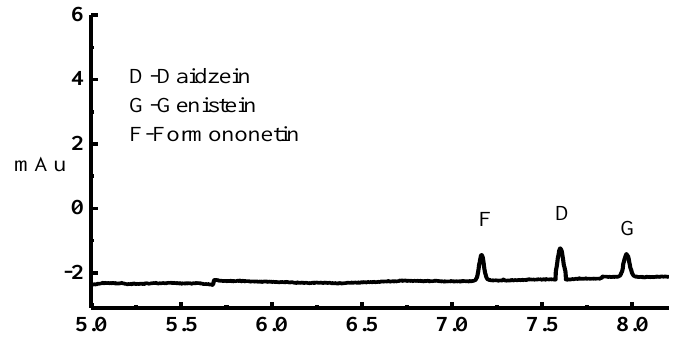
Figure 3. Electropherogram of the standard mixture of formononetin, daidzein and genistein.